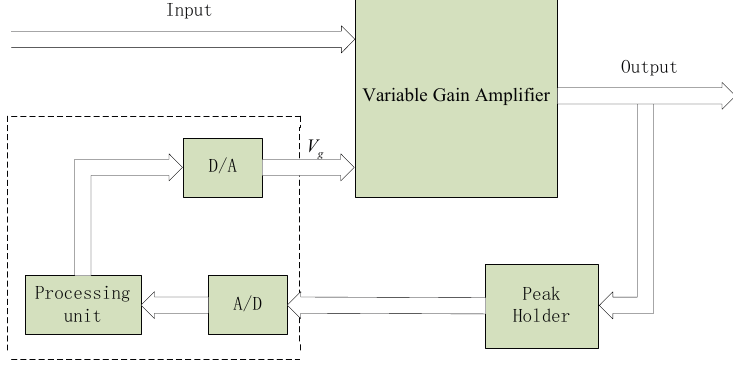
Figure 3. Block diagram of the AGC